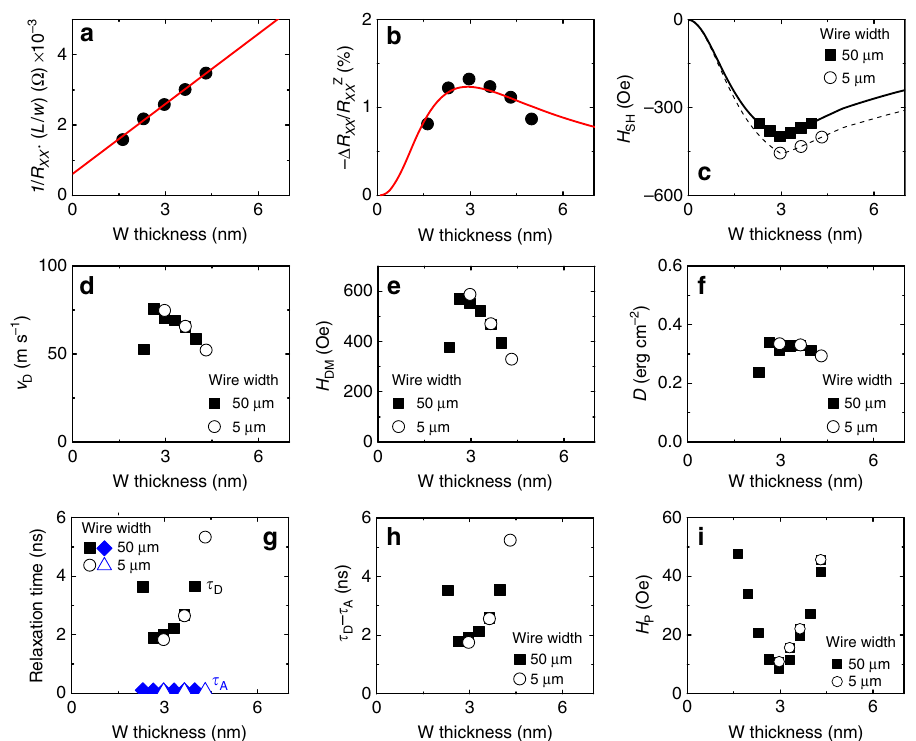
Figure 4 | Estimated acceleration and deceleration times of domain wall (DW) motion. ( a ) Normalized inverse resistance (1/ R XX ) as a function of the W layer thickness. w and L corresponds to the width and length of the wire. Data are fitted with a linear function (solid line) to obtain the resistivity of W. ( b ) Spin Hall magnetoresistance D R XX = R Z versus W layer thickness. The solid line shows the fitting result. ( c ) Spin Hall effective field H SH calculated using XX the solid line shown in b when a pulse with amplitude of 16V is applied to the wire. The solid and dashed lines display H SH for B 5 m m and B 50 m m wide wires, respectively. The symbols represent values of H SH used to calculate the acceleration time shown in g . ( d ) The saturation DW velocity ( v D ) estimated from fitting results of v END vs. pulse amplitude with Equation (1). ( e , f ) Calculated DM offset field H DM ( e ) and the DM exchange constant D ( f ). ( g ) W thickness dependence of the acceleration time ( t A ) and the deceleration time ( t D ) estimated using equations (2) and (3), respectively. Black squares (circles): t D for 50 m m (5 m m) wide wires, blue diamonds (triangles): t A for 50 m m (5 m m) wide wires. ( h ) Difference of t D and t A plotted against the